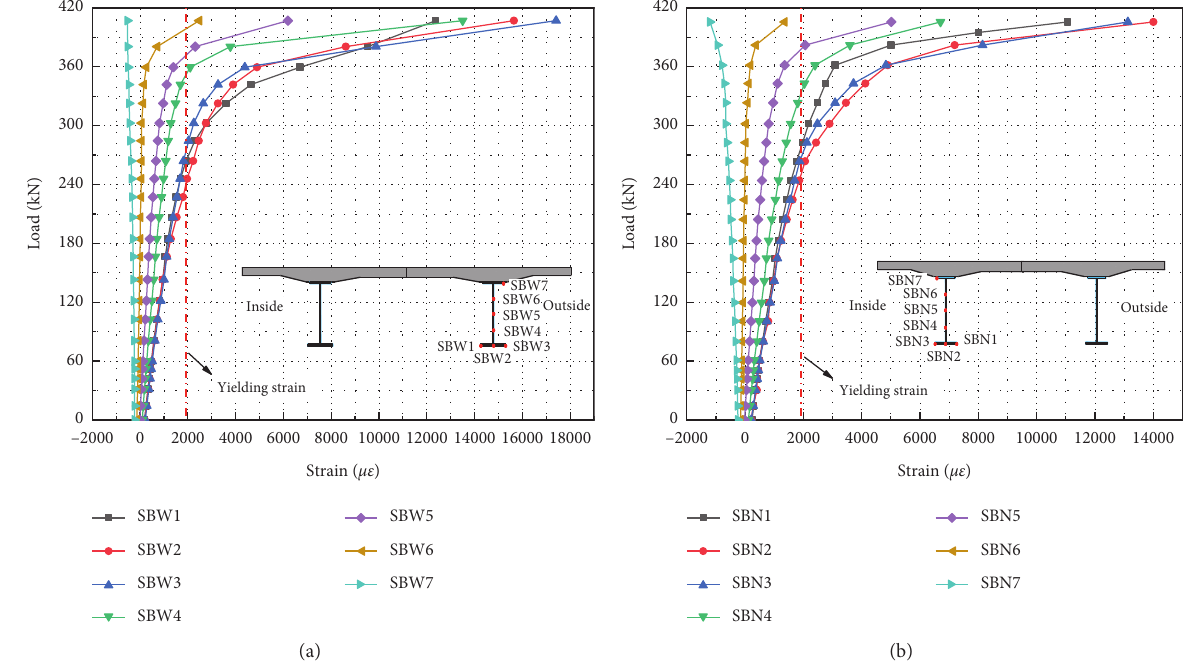
Figure 9: Load-strain curves of steel main girders at the loading section (a) on the external steel main girder and (b) on the internal steel main